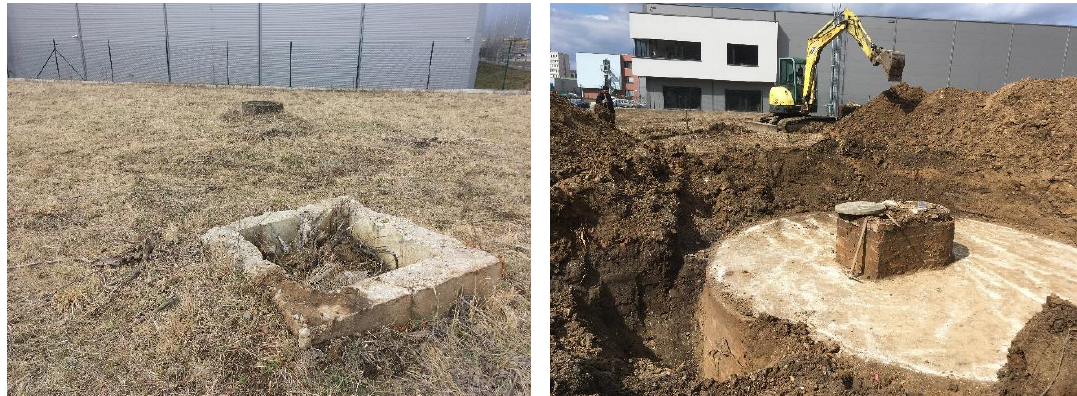
povolení vycházel pouze ze staršího topografického zaměření, geologických map a informací geologických průzkumů okolních budov v těsné blízkosti objektu.